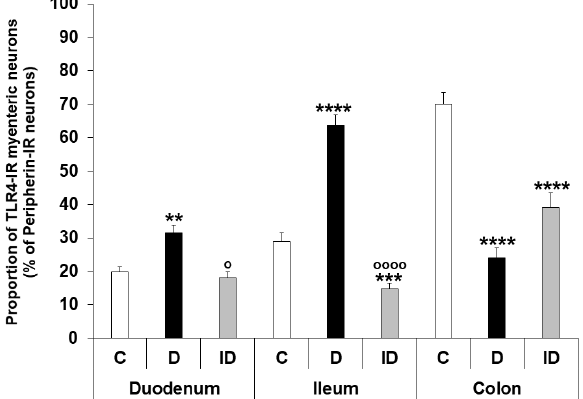
Figure 4. Proportion of TLR4-immunoreactive myenteric neurons of the duodenum, ileum, and colon of control, diabetic and insulin-treated diabetic rats. The proportion of TLR4-immunoreactive myenteric neurons was increased in the duodenum, robustly increased in the ileum and decreased in the colonic ganglia of diabetics relative to controls. The insulin treatment had regional protective effects on TLR4 expression. Statistics: Kruskal-Wallis test with Dunn’s multiple comparisons test. Data are expressed as mean ± SEM. ** p < 0.01, *** p < 0.001, **** p < 0.0001 (relative to controls); o p < 0.05, oooo p < 0.0001 (between diabetics and insulin-treated diabetics). C—controls, D—diabetics, ID—insulin-treated